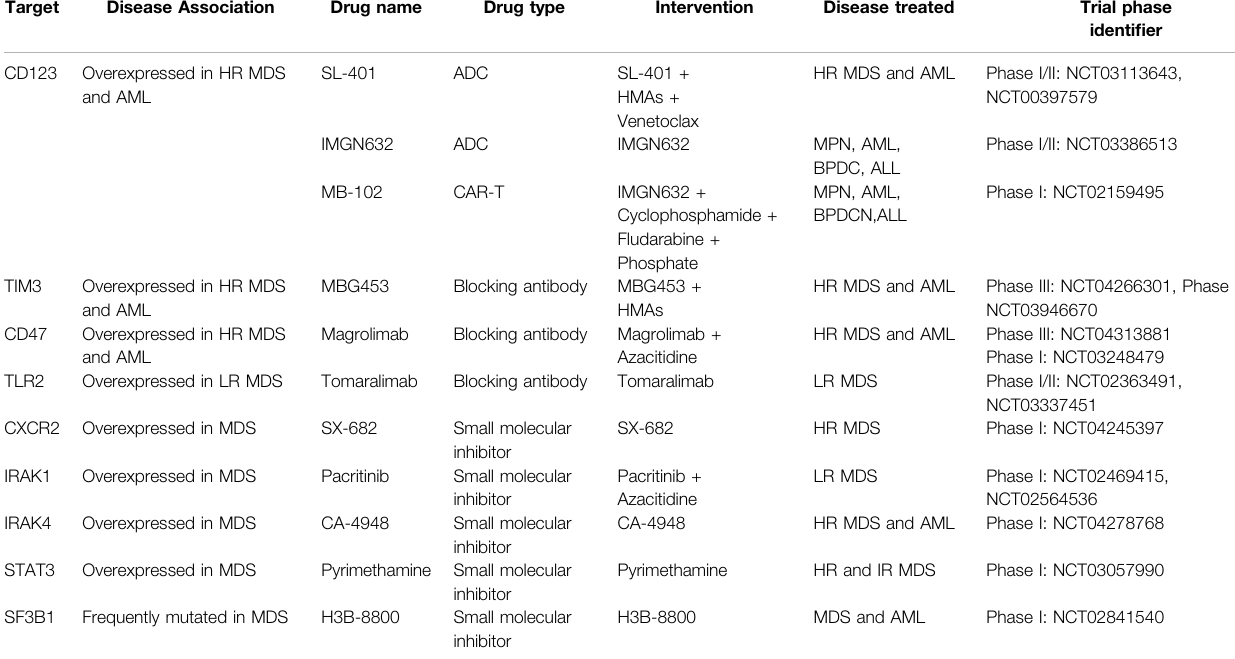
TABLE 1 | Therapies targeting MDS-SCs in clinical